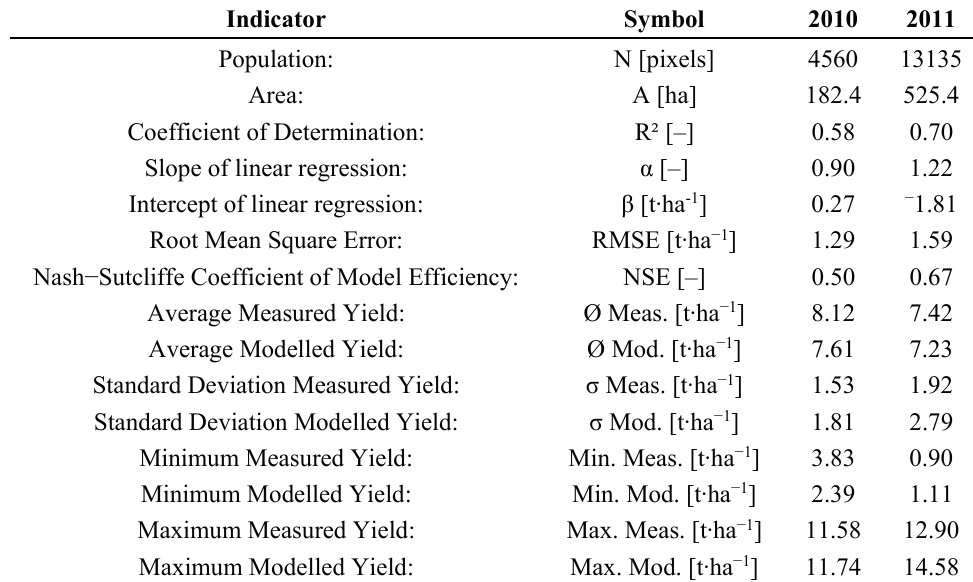
Figure 8. X-Y-Plots showing the correlation of modelled vs . measured yield of all winter wheat pixels for the two consecutive seasons of 2010 ( a ) and 2011 ( b ). The corresponding statistics are given in Table 6. Table 6. Statistics of the validation of winter wheat yield for the two consecutive seasons of 2010 and 2011 corresponding to the X-Y-plots displayed in Figure